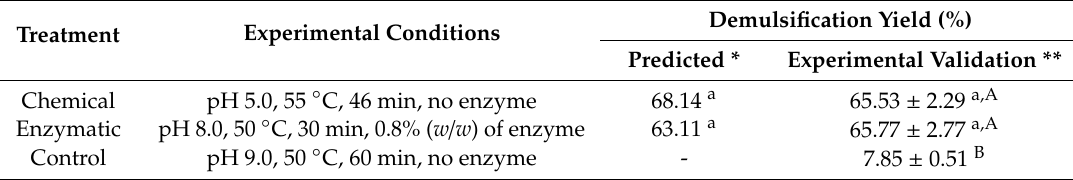
Table 6. Experimental validation of optimum enzymatic and chemical demulsification